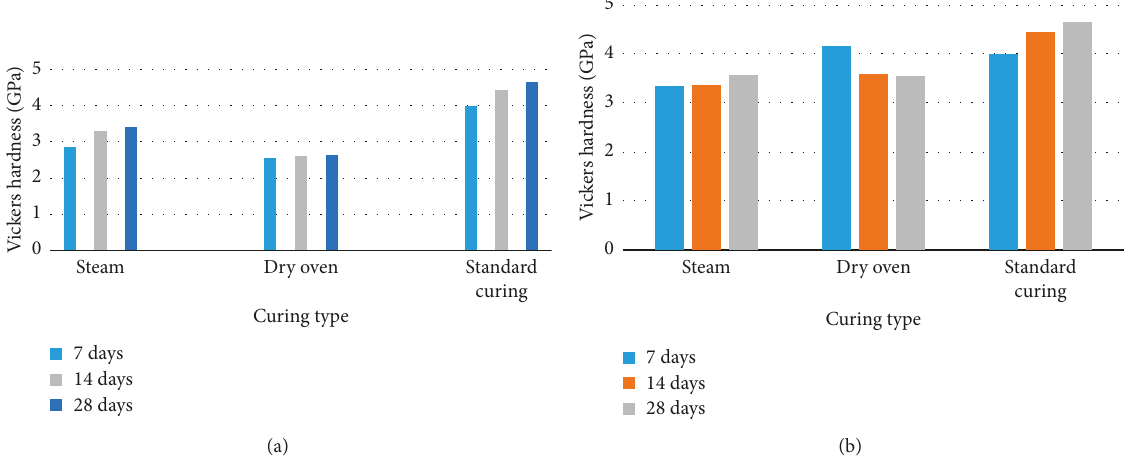
Figure 7: Vickers hardness of concrete specimens with a W/B ratio of 0.3 prepared and cured under different conditions at a temperature of (a) 30 ° C and (b) 50 ° C.